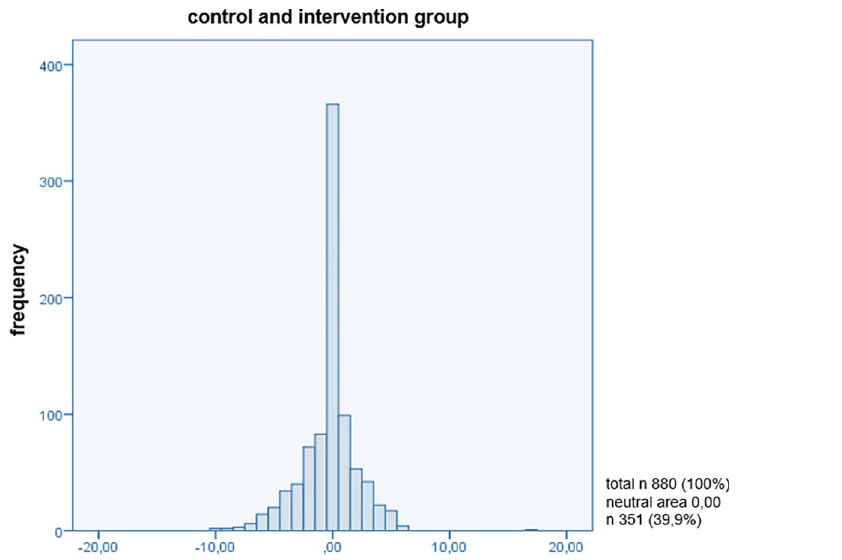
Fig 3. Control and intervention